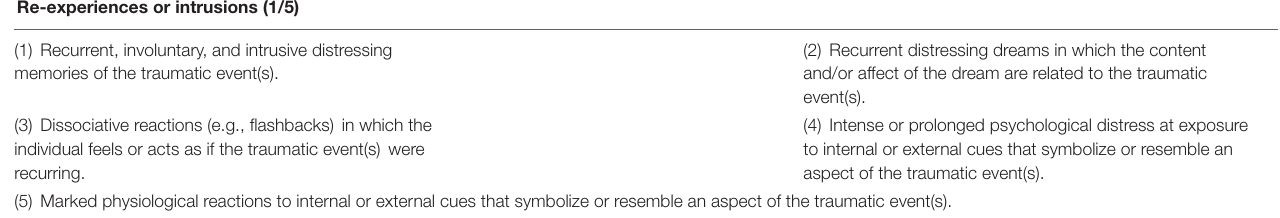
TABLE 2 | Summary of specific criteria and symptoms for the diagnosis of PTSD (American Psychiatric Association [APA], 2013). Re-experiences or intrusions